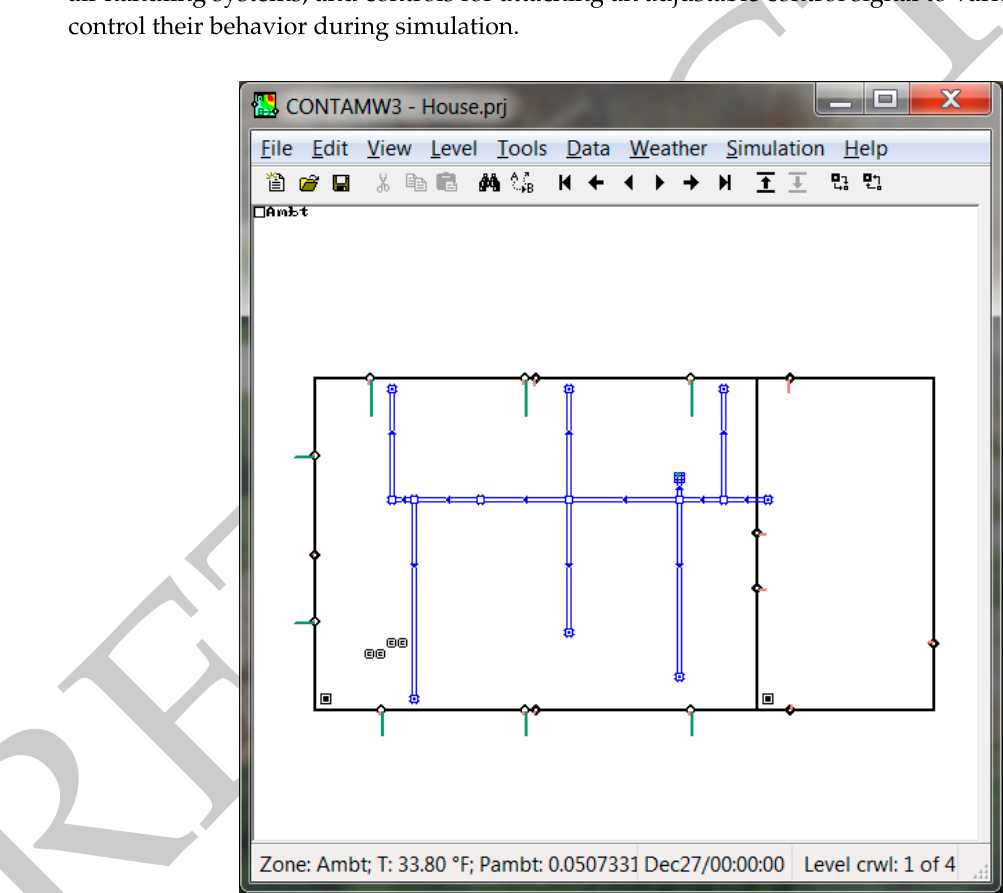
Figure 1. ContamW graphical simulation model editor. The experimental simulation model depicts a classroom with ventilation ductworks.